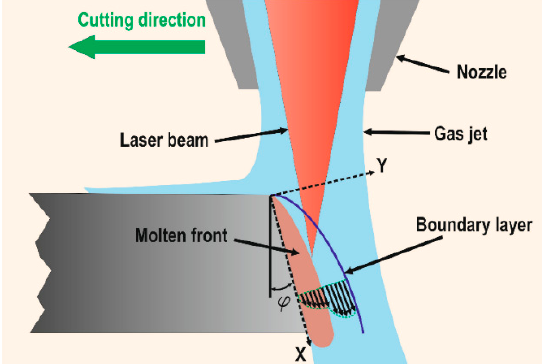
Figure 1. Scheme of the forces acting on the molten material during laser fusion cutting.